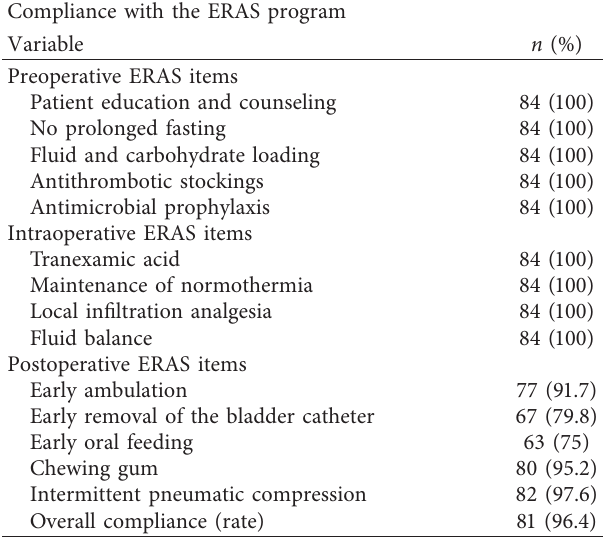
Table 2: ERAS pathway